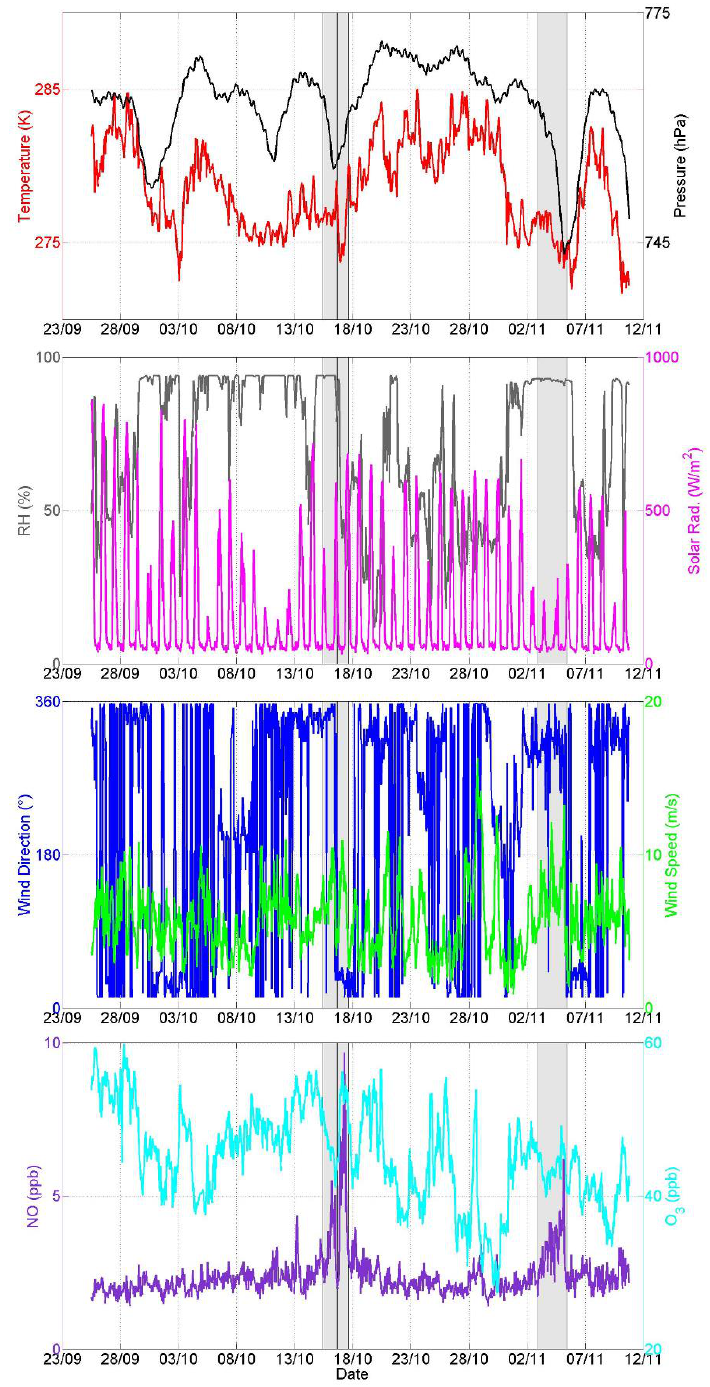
Figure 2. Time series of all the parameters of interest. The grey boxes highlight three plumes in the NO trend: two very close on 16 and 17 of October and the last on November (3–5 November 2013). As expected in a remote site, the diurnal trend of NO and O 3 does not show the typical evolution like in an urban environment where they are strongly linked to the photochemistry (Figure 2).